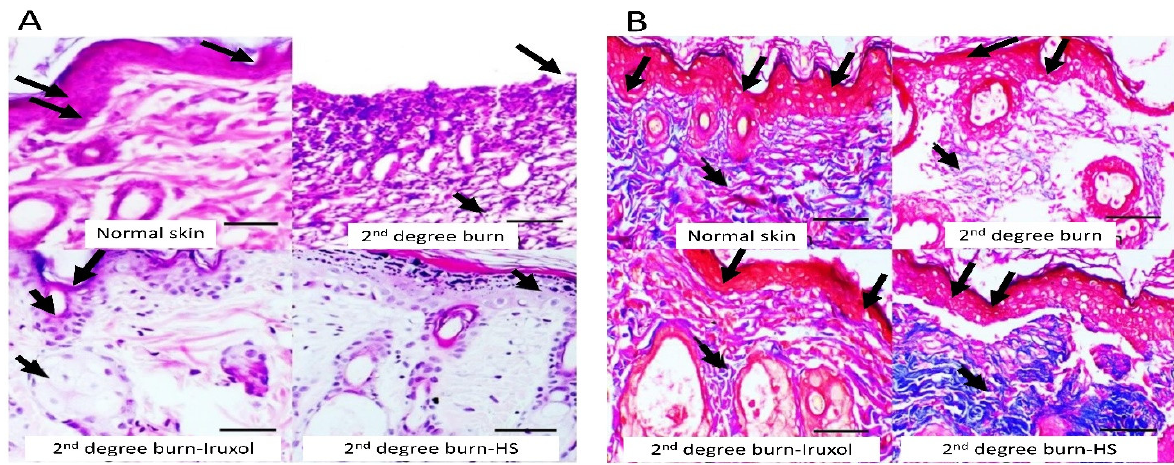
Figure 3. Histopathological examination of skin tissues from different groups by H&E staining. The left panel ( A ) shows histopathological examination of skin tissues from different groups by H&E staining, ×200. The normal epidermal layer formed of stratified epithelium with marked keratiniza- tion and normal dermal layer (arrows). The 2nd degree burn group exhibited a minimal degree of epithelialization (arrow) with subepithelial edema (short arrow). In contrast, treatment with Iruxol resulted in marked epithelialization degree (arrow) and normal dermal hair follicle appendages (short arrow). Treatment with HS resulted in marked epithelialization (short arrow). Bar = 100 µm. The right panel ( B ) illustrates the Masson’s trichrome staining, ×200. Masson’s trichrome staining indicated the normal dermal layer (arrows) and primary parallel collagen (short arrow). The 2nd degree burn group was associated with disturbed epithelia (arrows) and massive dermal collagen formation (short arrow). In contrast, treatment with Iruxol resulted in a less disturbed dermal layer (arrows) and minimal dermal collagen formation (short arrow). Additionally, treatment with HS resulted in a less disturbed dermal layer (arrows) and minimal dermal collagen formation (short arrow). Bar = 100 µm. 3.4. Immunostaining of IL-6 A marked expression of IL-6 within the dermal layer of the burn group, as indicated upon calculation of the % immunopositive cells/1000 counted cell was clearly displayed. While the treated groups with either Iruxol or HS showed a marked decrease in the ex- pression of IL-6 (Figure 4). Figure 4. Immunohistochemical detection of IL-6 in skin tissues. Immunohistochemical detection of IL-6 in skin tissues, ×200. Arrows indicate expression of IL-6 within the dermal layers of different groups. Marked immunolabeling was detected in the 2nd degree burn group of rats, while